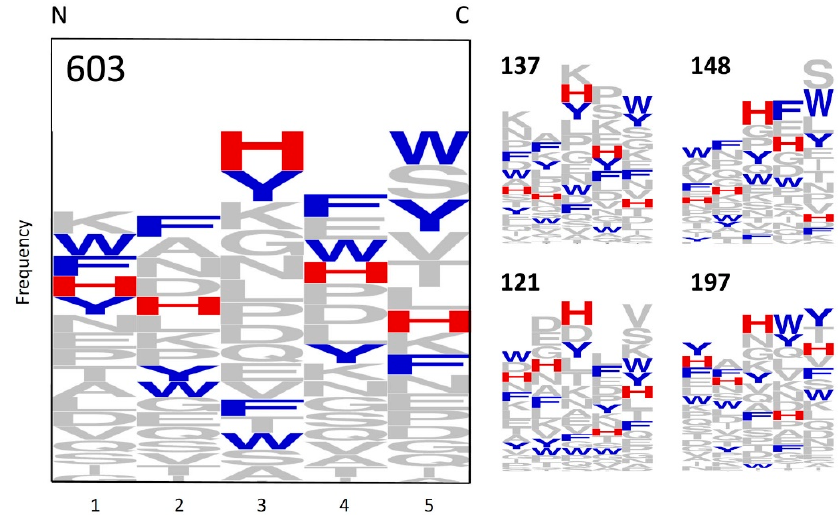
Figure 2. Summary of the bead screening results of a 5mer general library against C-peptide. Histidine, the aromatic residues (phenylalanine, tyrosine, and tryptophan), and the remaining residues are respectively highlighted in red, blue, and grey. The numbers indicate the number of peptide sequences successfully sequenced. The histogram on the left represents the composite results of the four separate rounds of screening (on the right) with the 5mer general library. The histograms are prepared with the publicly available WebLogo program [30]. These results show that it is consistently favourable for His to be in position 3.